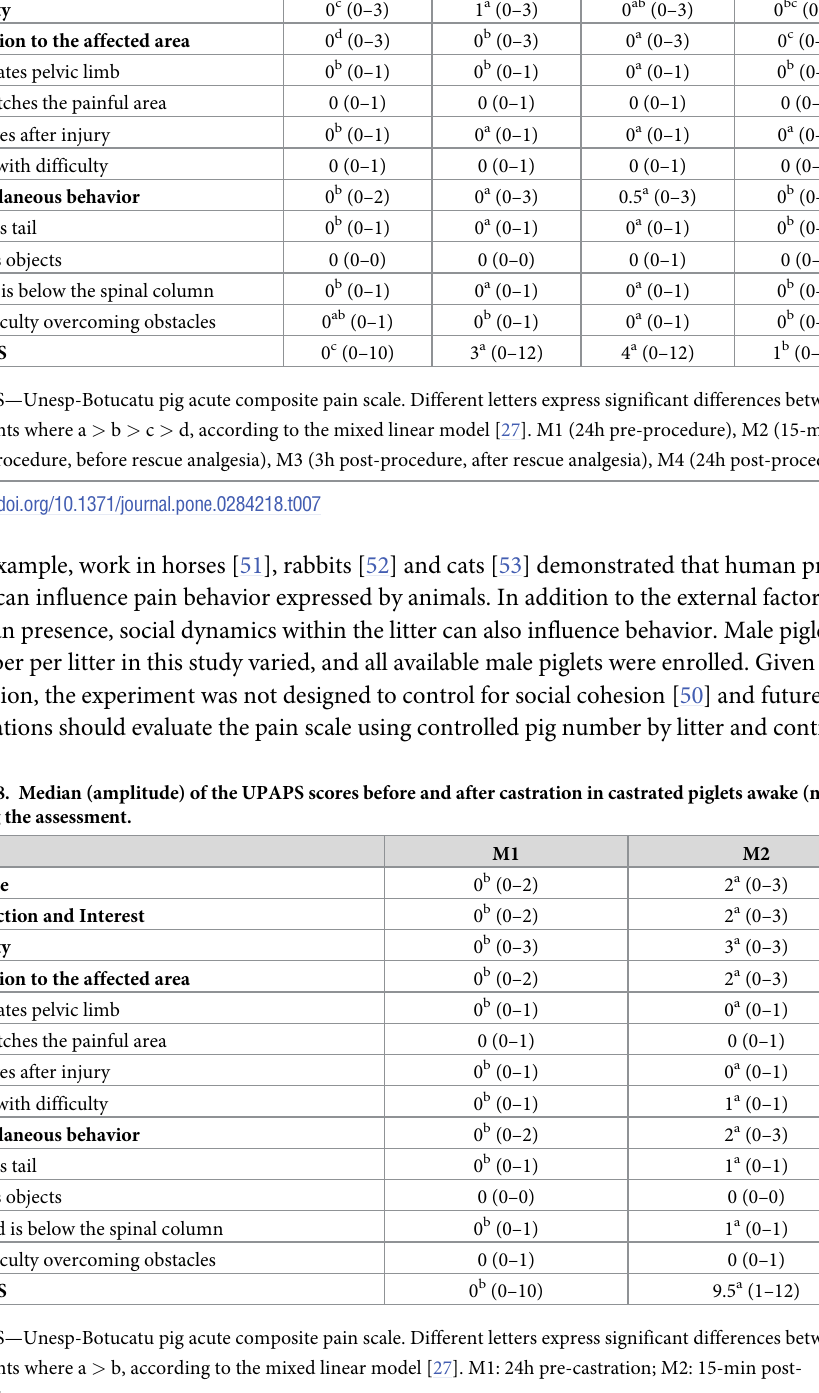
Table 7. Median (amplitude) of the UPAPS scores before and after castration in all castrated piglets (n = 39). Behavioral pain scale items M1 M2 M3 M4 Posture 0 b (0–2) Interaction and Interest 0 d (0–2) Activity 0 c (0–3) 1 a (0–3) Attention to the affected area